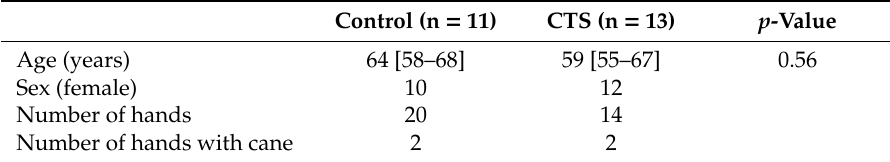
Table 1. Demographic features in the control and CTS groups.